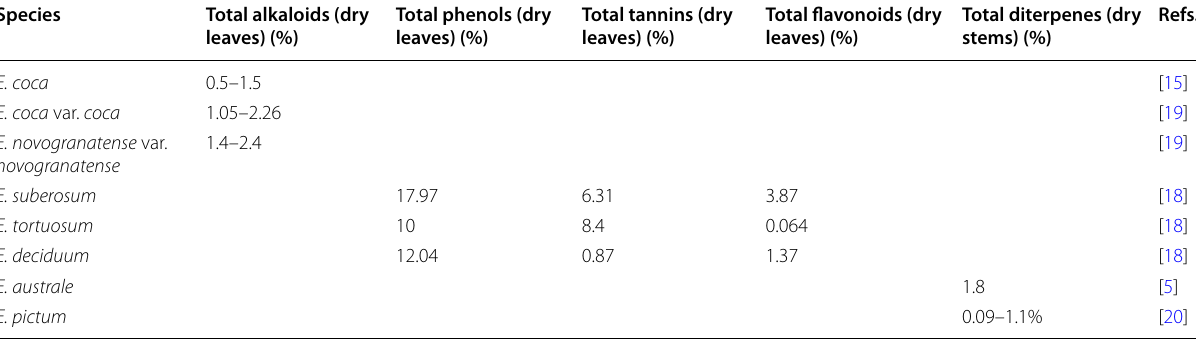
Tabel 1 The content of principal components in several Erythroxylum species